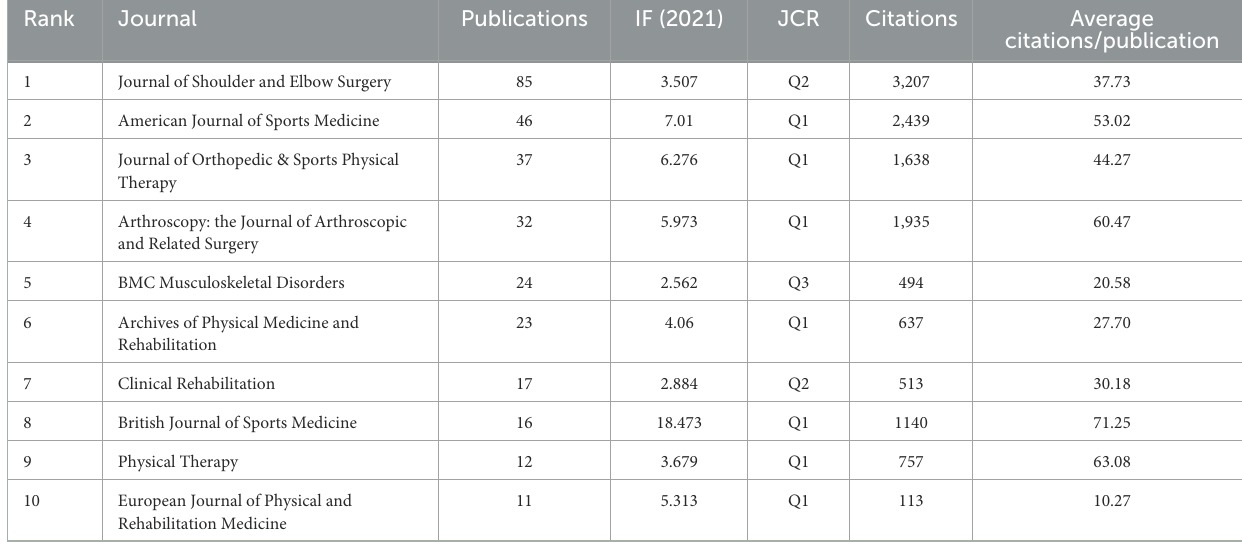
TABLE 3 Top 10 journals contributed to publications on the rehabilitation of